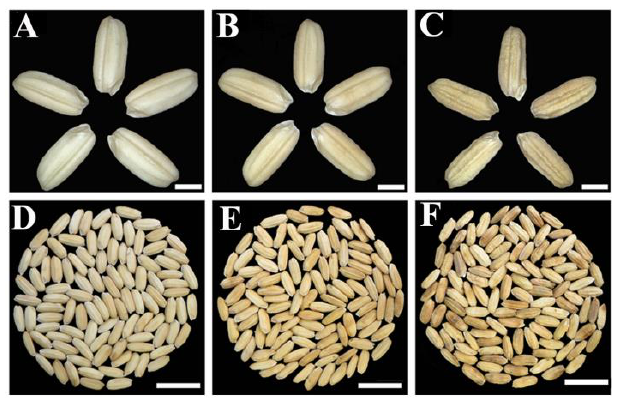
Figure 2. Morphology of non-shrunken ( A , D ), slightly shrunken ( B , E ), and moderately shrunken seeds ( C , F ). Scale bar = 2 mm for ( A – C ) and 5 mm for ( D – F ).